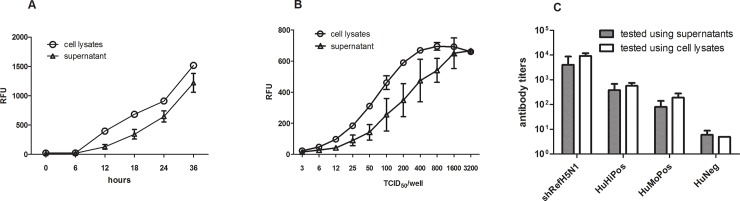
Comparison of NA activity between cell lysates and supernatants.(A) NA activity in cell lysates and supernatants at different time points following infection. Cells were infected with NIBRG-14 (H5N1) virus at a multiplicity of infection of 0.001. Each data point represents the mean of three separate experiments. (B) NA activity in cell lysates and supernatants with different viral inocula. MDCK cells were infected with different dilutions of NIBRG-14, with NA activity measured in either the cell culture supernatant or cell lysates 20 h after inoculation. The total NA activity in the supernatants was calculated and compared with the activity in the cell lysates. (C) The neutralizing antibody titers of serum samples measured by the NA-MNT. The neutralizing antibody titer of NIBSC reference sheep antisera (shRef H5N1), high (huHiPos) and moderate (HuMoPos) seropositive samples, and negative (huNeg) human sera were determined by NA-MNT using either cell supernatants or lysates. Each test was repeated five times, with the CVs calculated accordingly. Note: HuHiPos, HuMoPos, and huNeg samples were obtained from a clinical study of the H5N1 candidate vaccine.